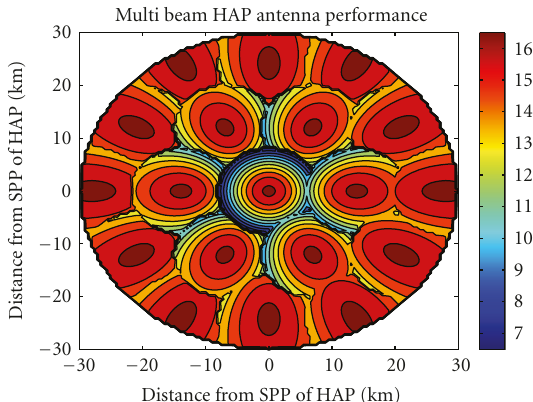
Figure 5: HAP cellular antenna payload performance.